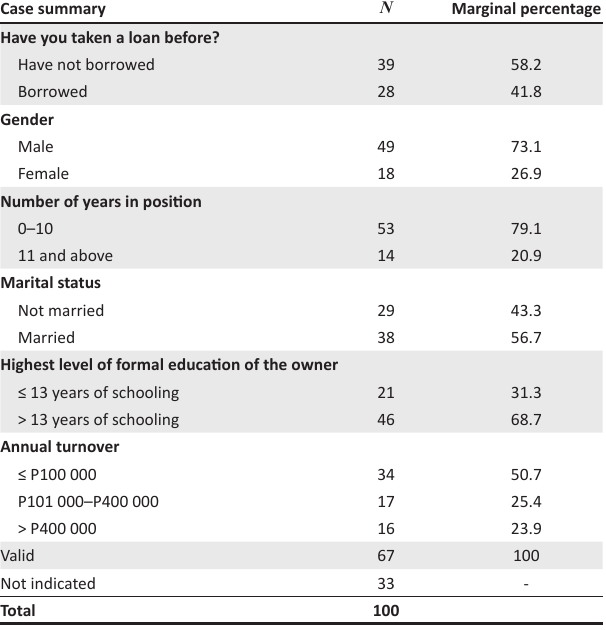
FIGURE 1: How small, medium and micro-sized enterprises initially financed their business ( N = TABLE 4a: Variables used in the multivariate regression analysis.